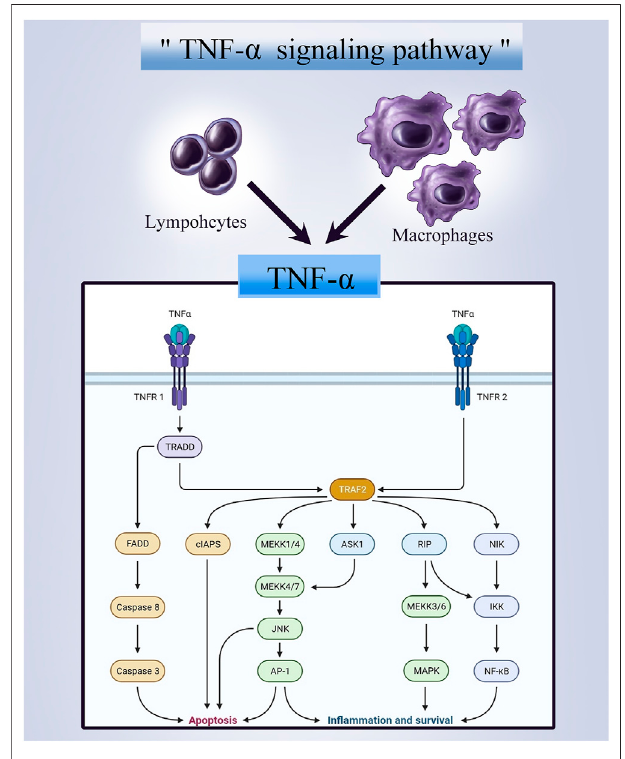
FIGURE 1 | A graphical representation of the TNF-alpha signaling